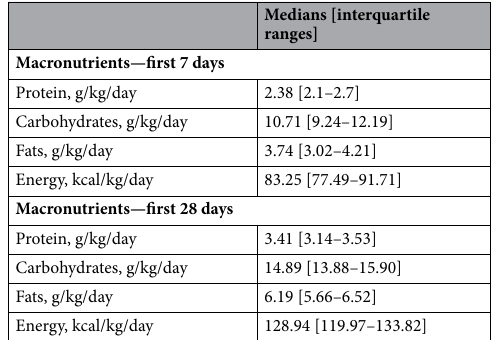
Medians [interquartile